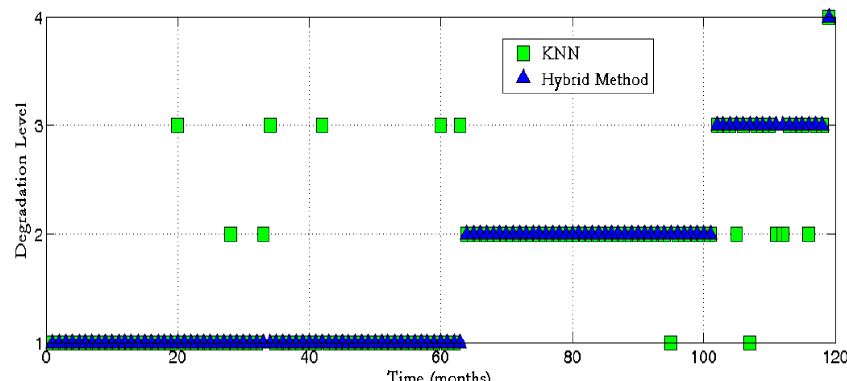
Figure 6. Example of observed sequence (squares) and estimated degradation state sequence (triangle).